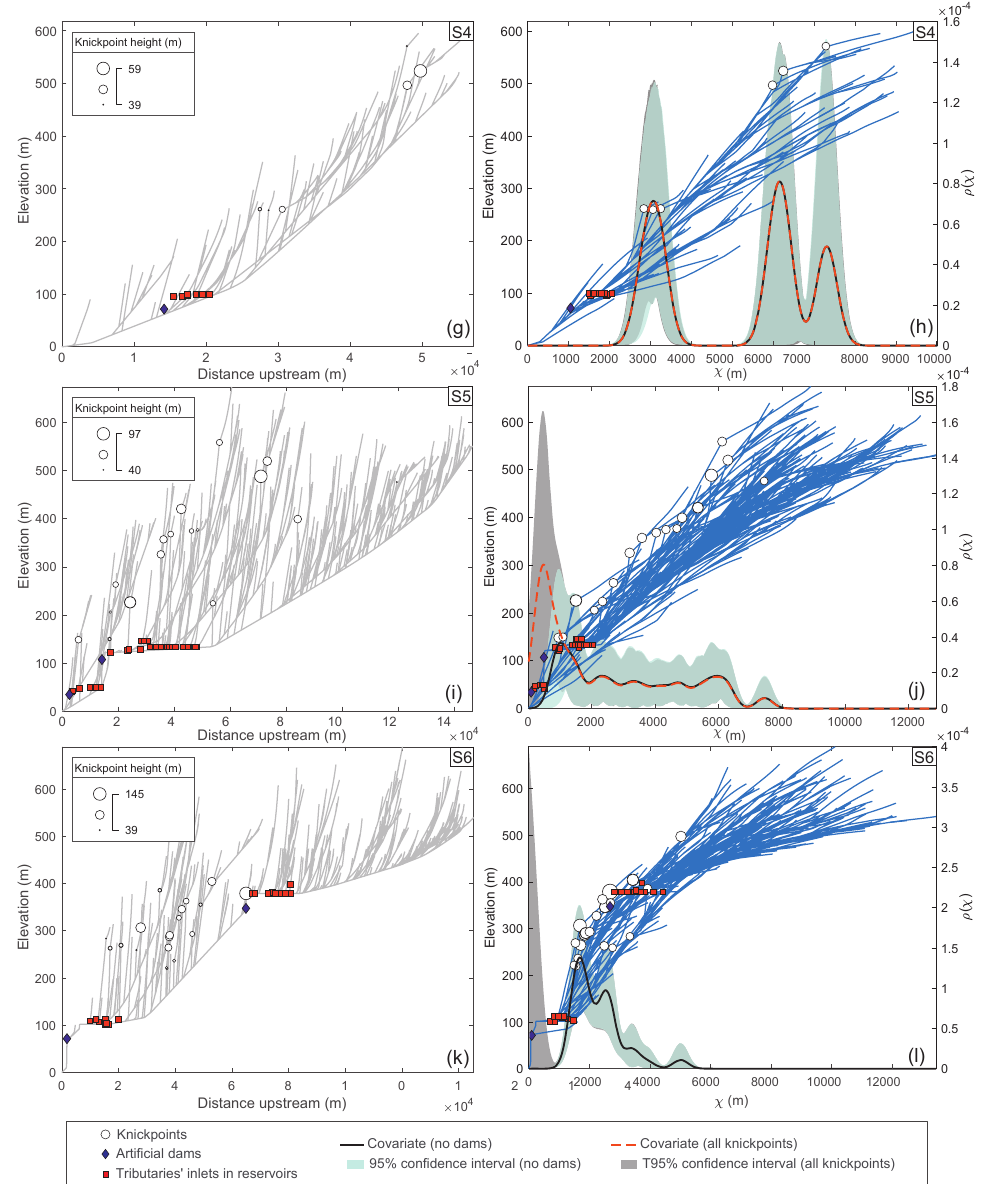
Figure 9. Knickpoint distribution along the S1–S6 stream networks. (a, c, e, g, i, k) River longitudinal profiles. (b, d, f, h, j, l) χ -transformed longitudinal profiles. The covariance estimates for knickpoints, calculated on the χ -transformed distance from the outlet (spatial covariate) with and without dams, indicate the probability of having knickpoints along the transformed profile. Knickpoints sized by height, artificial dams, and tributary inlets into the reservoirs are projected on